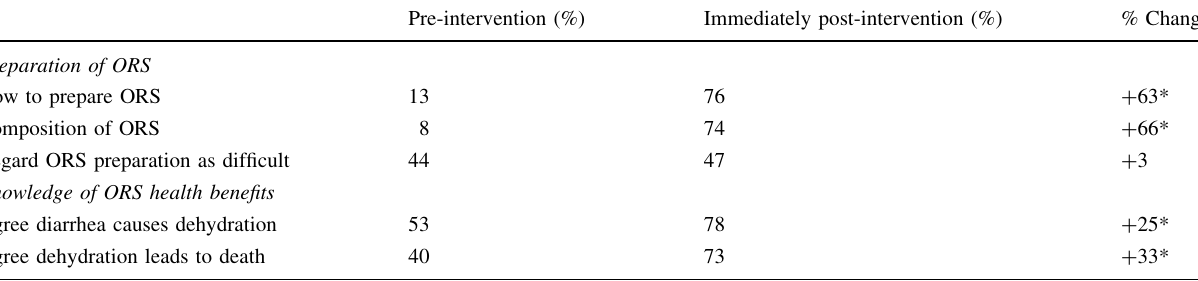
Table 3 Results of the 2014 pre- and post-intervention household questionnaire on ORS-related knowledge ( n = 100) in Hongyan